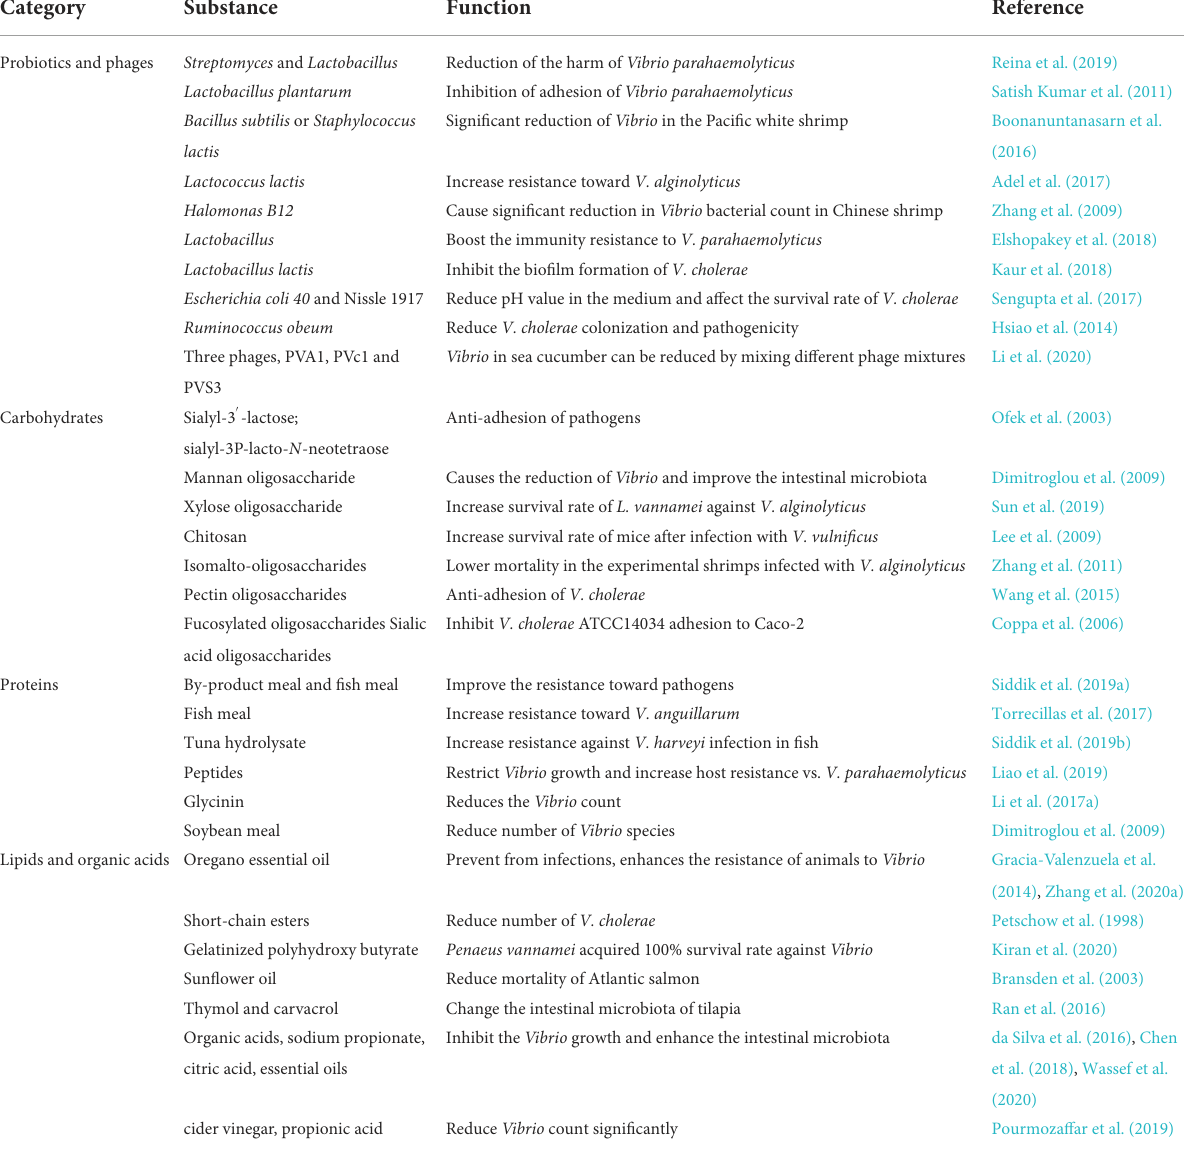
TABLE 2 Dietary intervention on Vibrio pathogenicity by regulating the intestinal